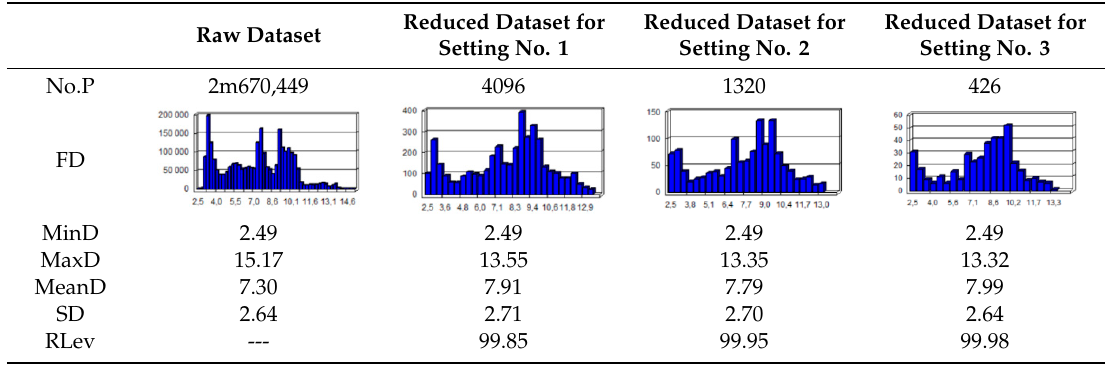
Table 2. Statistics for points reduced with the TBDRed method based on the LNG port area.